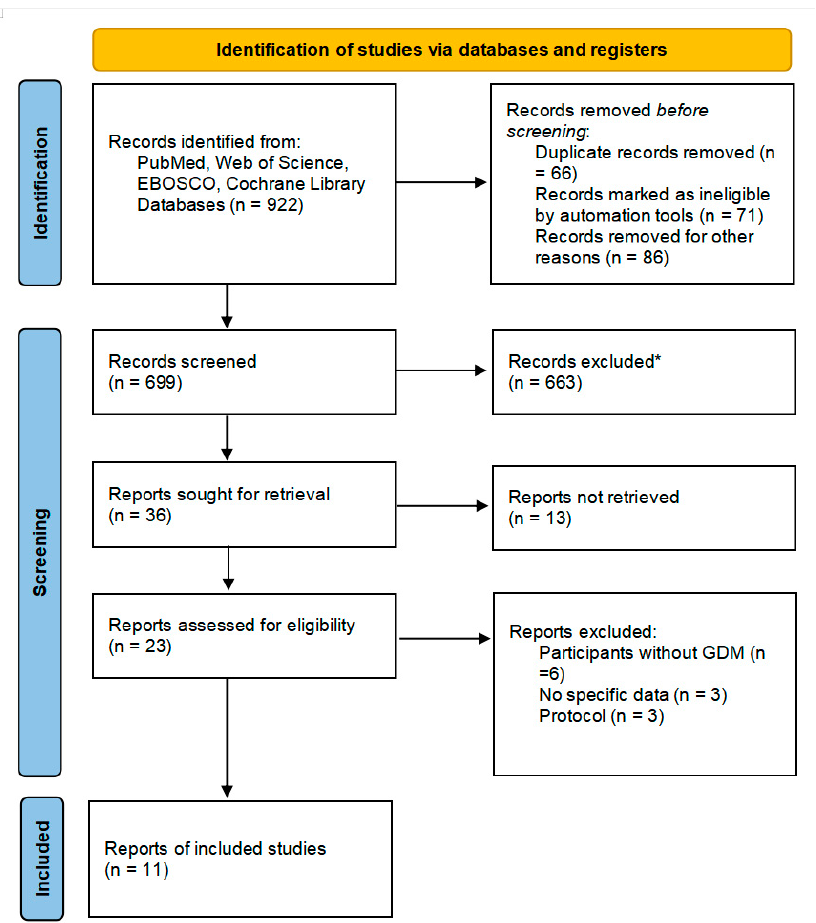
Figure 1. Flow diagram describing inclusion and exclusion criteria. * Automation tools were used; 201 were excluded by automation tools applying filters (animals, review, meta-analysis, and year of publication); and 462 records were excluded by a human.